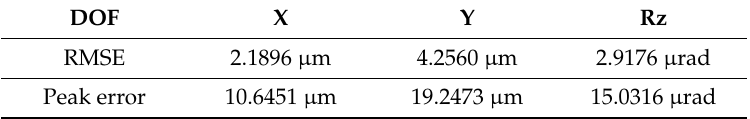
Table 4. The statistics of the horizontal 3-DOFs’ outputs with optimized parameters using Model